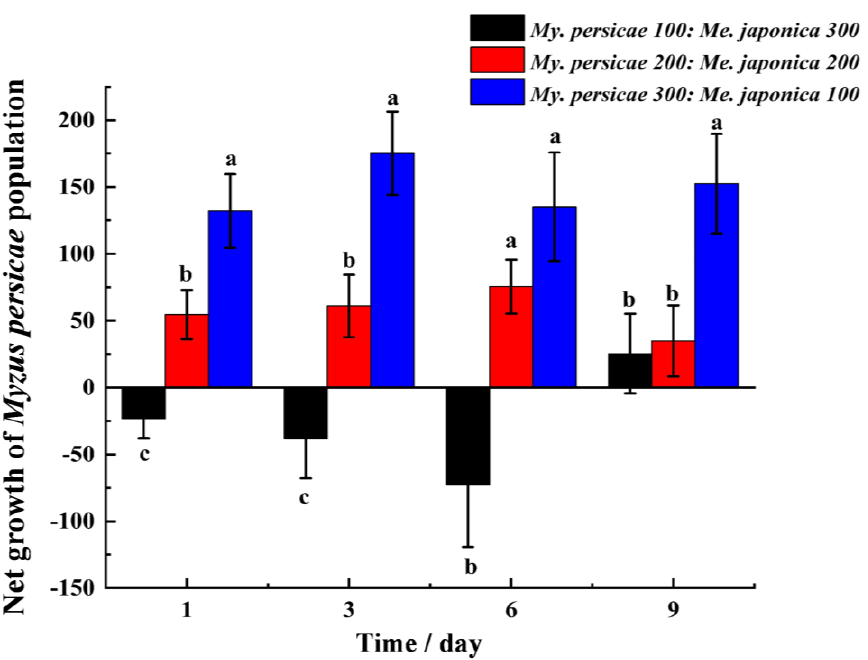
Figure 4. The population dynamics of Myzus persicae ( A ) and Megoura japonica ( B ) at different initial ratios. My. p represents My. persicae , and Me. j represents Me. japonica .